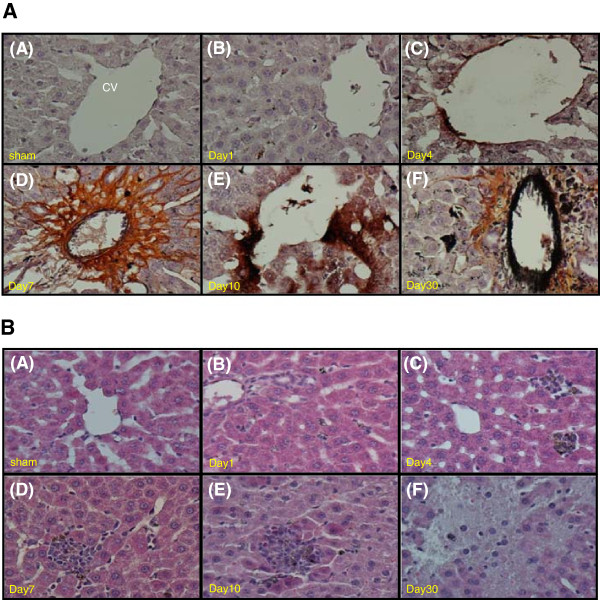
Histopathological observation of rat liver. Intrahepatic distribution of Ag-nps (A), and histopathological changes in liver tissues at different time points (B) after i.p. injection of Ag-nps. Experiments were carried out as described under Materials and Methods using silver enhancement stain and hematoxylin and eosin stain. A: section thickness was 5-μm. Ag-nps images were taken by optical microscopy with 200× amplifications. B: high magnification of livers (400×).